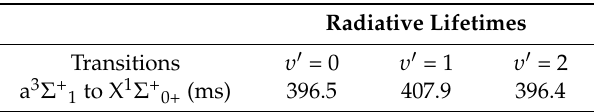
Table 4. Radiative lifetime values of the transition from the a 3 Σ + 1 ( υ (cid:48) = 0–2) excited Ω states to the X 1 Σ + 0+ state for the SiN −